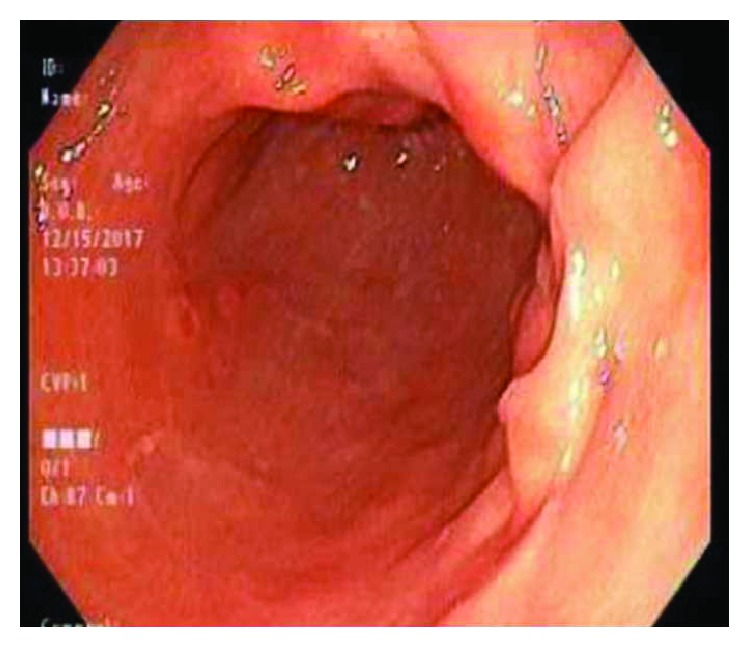
Body of the stomach.